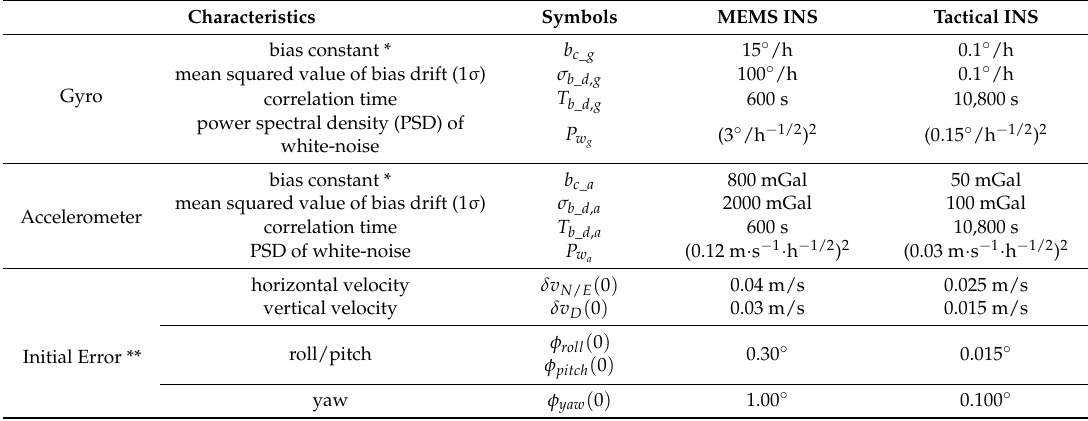
Figure 4. Vehicle in high dynamic uniform acceleration linear motion along the north direction. Table 1. Non-maneuver-dependent error specifications of different grades of INS.